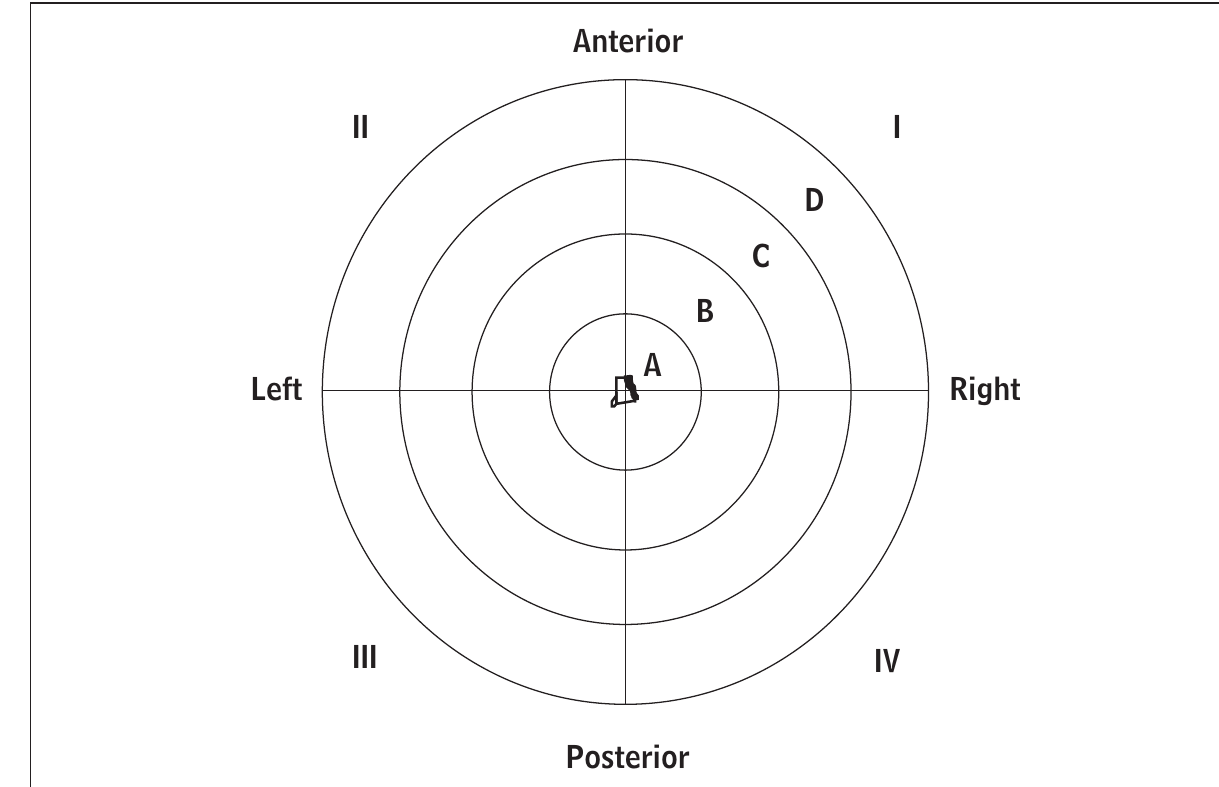
Figura 2 – Protocolo do Teste de Risco de Quedas no BBS Fonte: Balance System SD 2